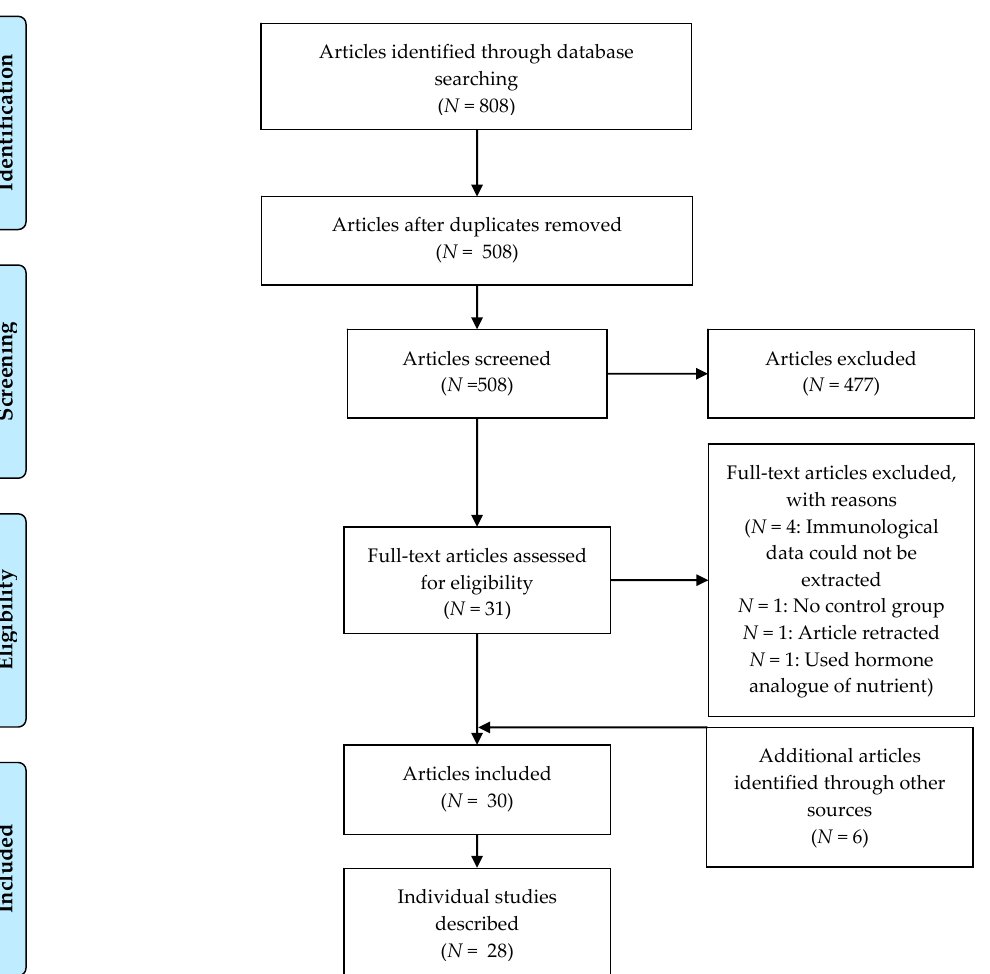
Figure 1. PRISMA flow diagram of study selection. In total, 30 articles describing 28 studies were included in the review.